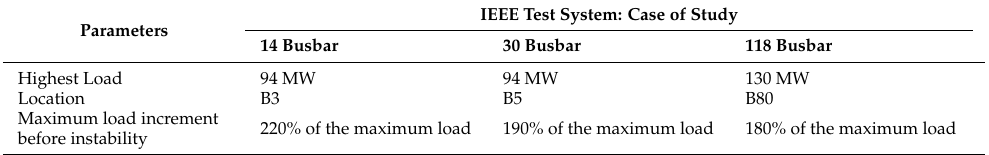
Table 2. Maximum load restrictions for study cases in the IEEE 14, 30 and 118 busbar